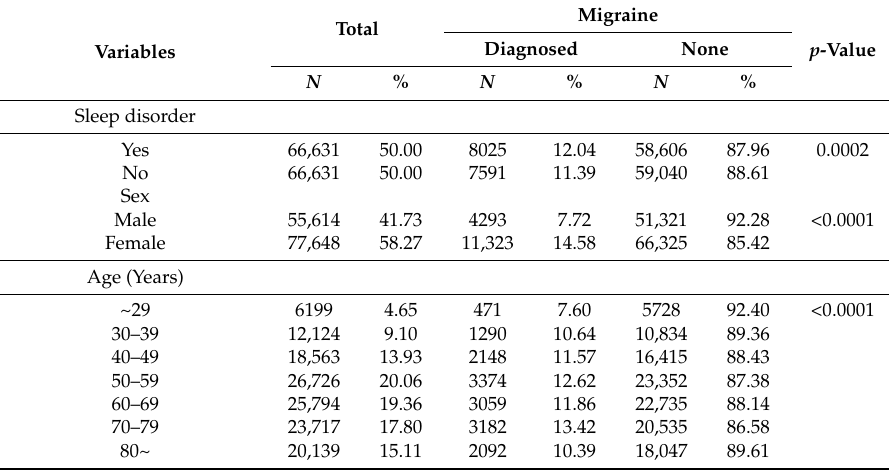
Table 1. General characteristics of the study